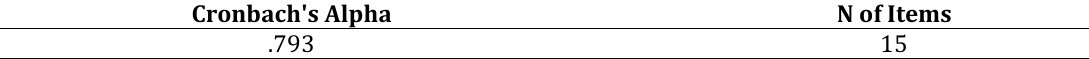
Table 5: reliability